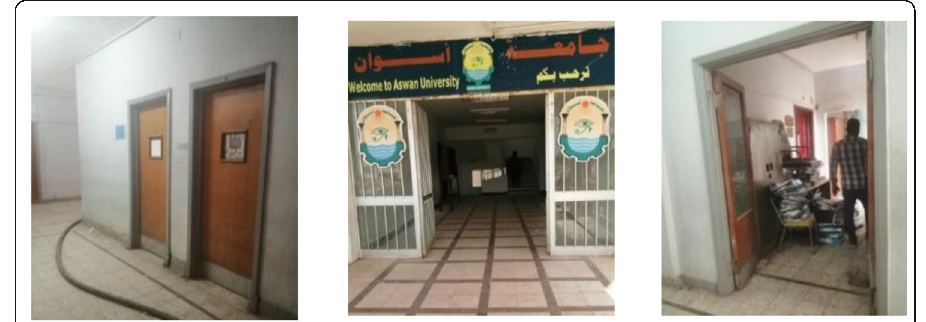
Fig. 14 The interior doors ’ widths are 80 – 90 cm